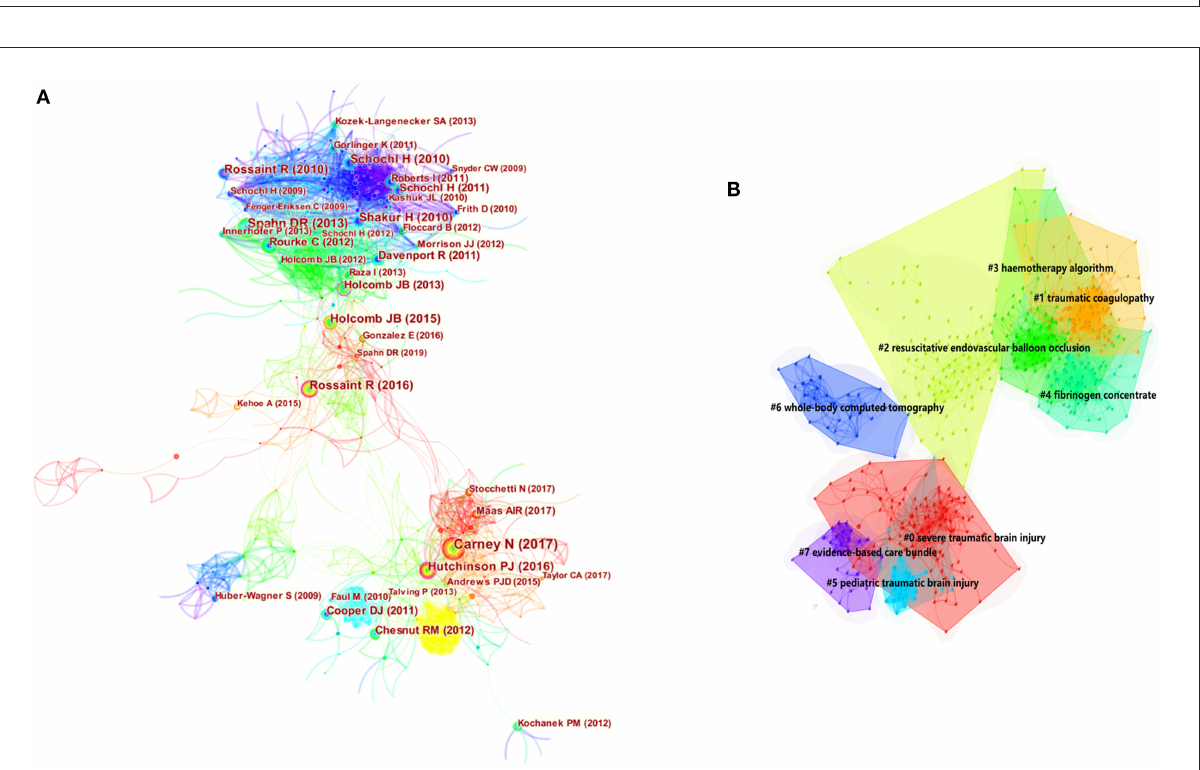
FIGURE6 Visual analysis of co-citation (A) and clustering network (B) . Each circle represents a reference. The size of the circle is proportional to the citation frequency. The link between the two circles represents two references cited in the same article among the citing articles. Line thickness is positively correlated with co-citation